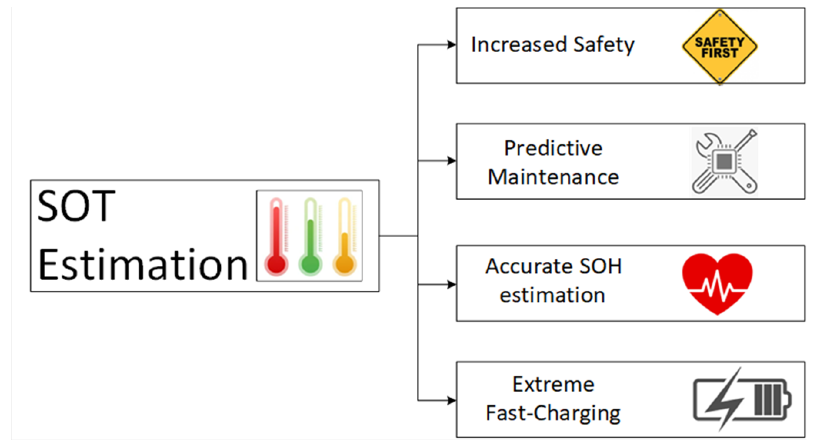
Figure 6. Smart Battery functionalities enabled by SOT estimation.